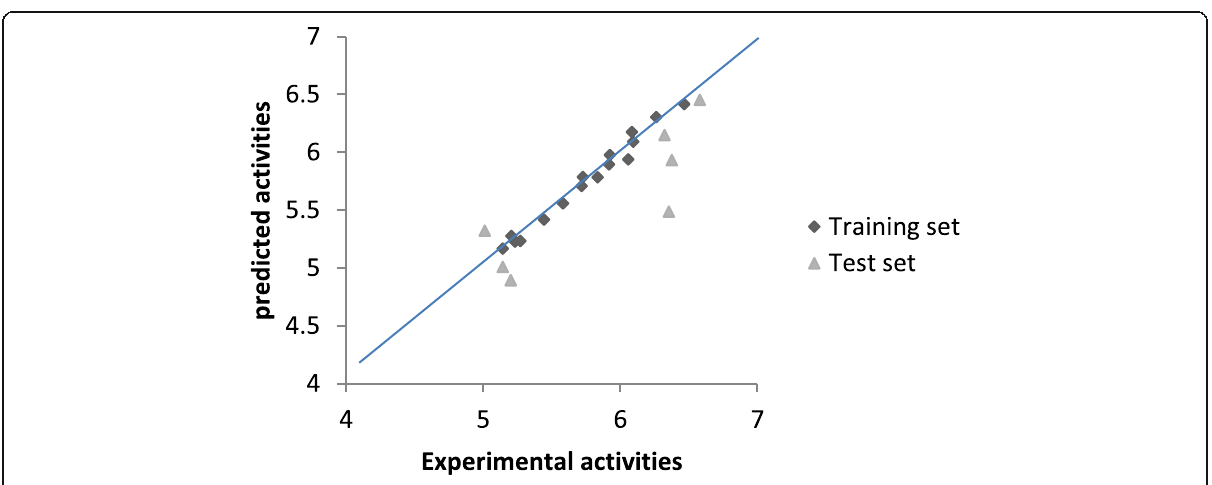
Fig. 1 Plot of predicted activities against experimental activities of the